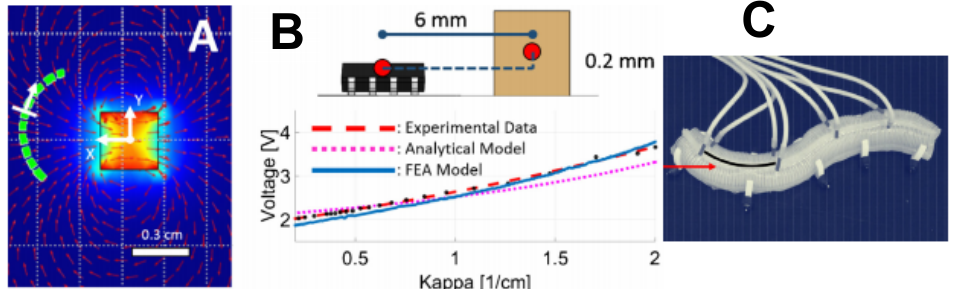
Figure 19. The function of a hall e ff ect sensor in an EMS ( A ), the distance between the magnet and hall e ff ect sensor in the curvature sensor presented by Ozel et al. ( B ), and the data correlating the accuracy of the models to the curvature sensor design ( C ) [137] (Open Access).